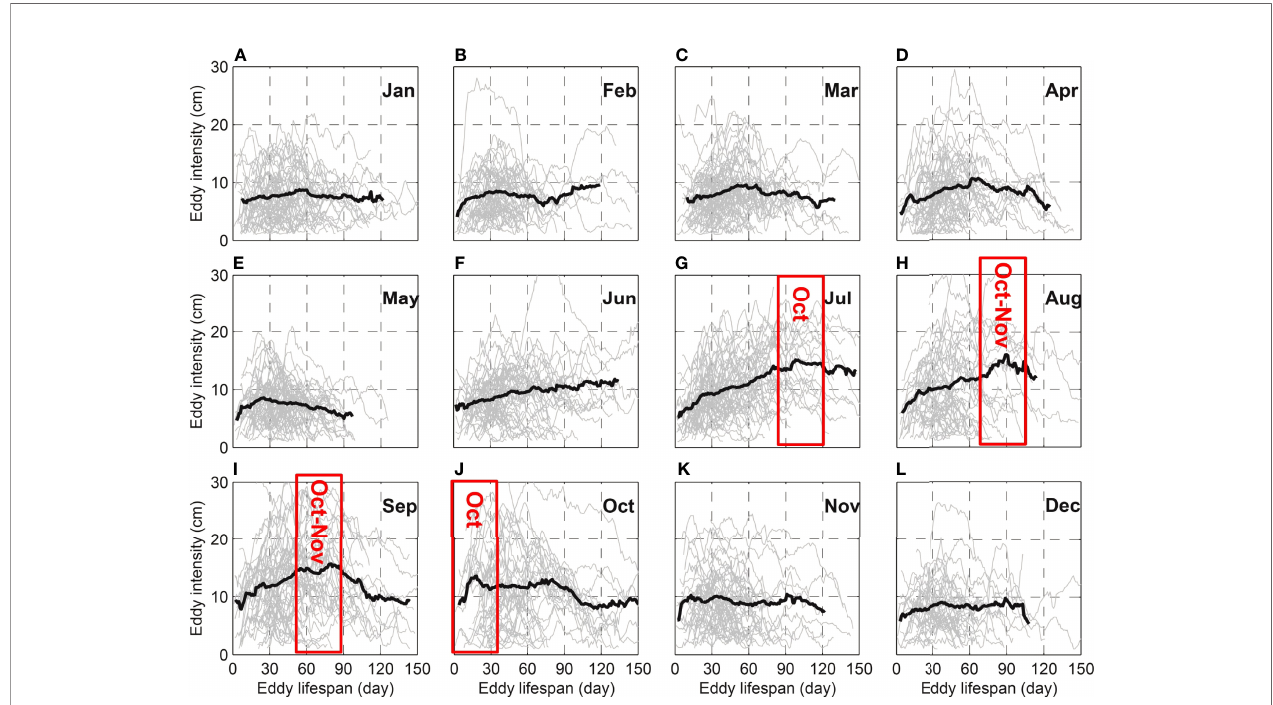
FIGURE 4 | Variation of the magnitude of eddies formed in each calendar month (A – L) during their lifetime. Gray lines represent individual eddies, and black lines are the means. Only eddies with life span longer than 30 days are plotted. Each panel not only shows the monthly results but also contains information regarding the evolution of eddy intensity for the next 4 months. The red box marks the peak of eddy intensity and corresponding